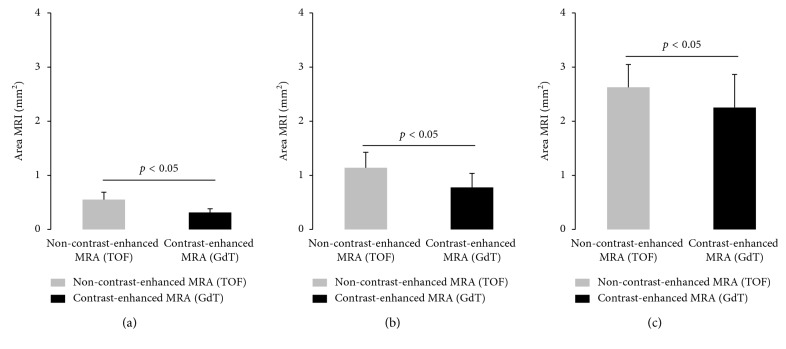
Area measurements of the aorta, brachiocephalic artery, and carotid artery on non-contrast-enhanced and contrast-enhanced MR angiographies. The diagram presents the luminal area measurements of the aorta, brachiocephalic artery, and carotid artery in mm2. Luminal area measurements based on the non-contrast-enhanced MR angiography (TOF) demonstrated significantly higher area measurements for the carotid artery (0.55 ± 0.14 mm2; p < 0.05), the brachiocephalic artery (1.14 ± 0.29 mm2; p ≤ 0.05), and the aorta (2.63 ± 0.42 mm2; p ≤ 0.05) compared to the contrast-enhanced MR angiography (GdT). Luminal area measurements for the contrast-enhanced MR angiography following the administration of gadofosveset trisodium were as follows: carotid artery (0.31 ± 0.07 mm2), brachiocephalic artery (0.78 ± 0.26 mm2), and aorta (2.25 ± 0.61 mm2). (a) MRA CA. (b) MRA BCA. (c) MRA aorta.